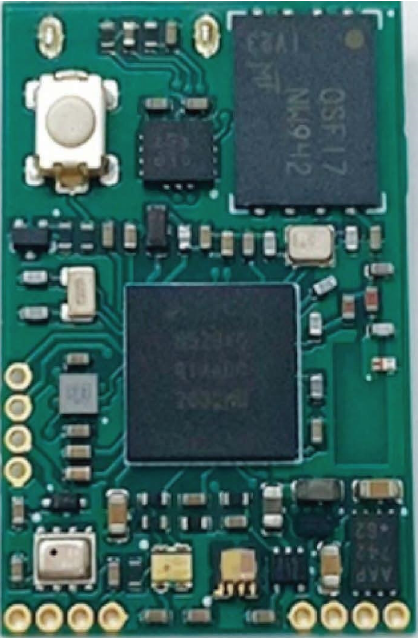
Figure 3: Mbientlab Meta sensor.